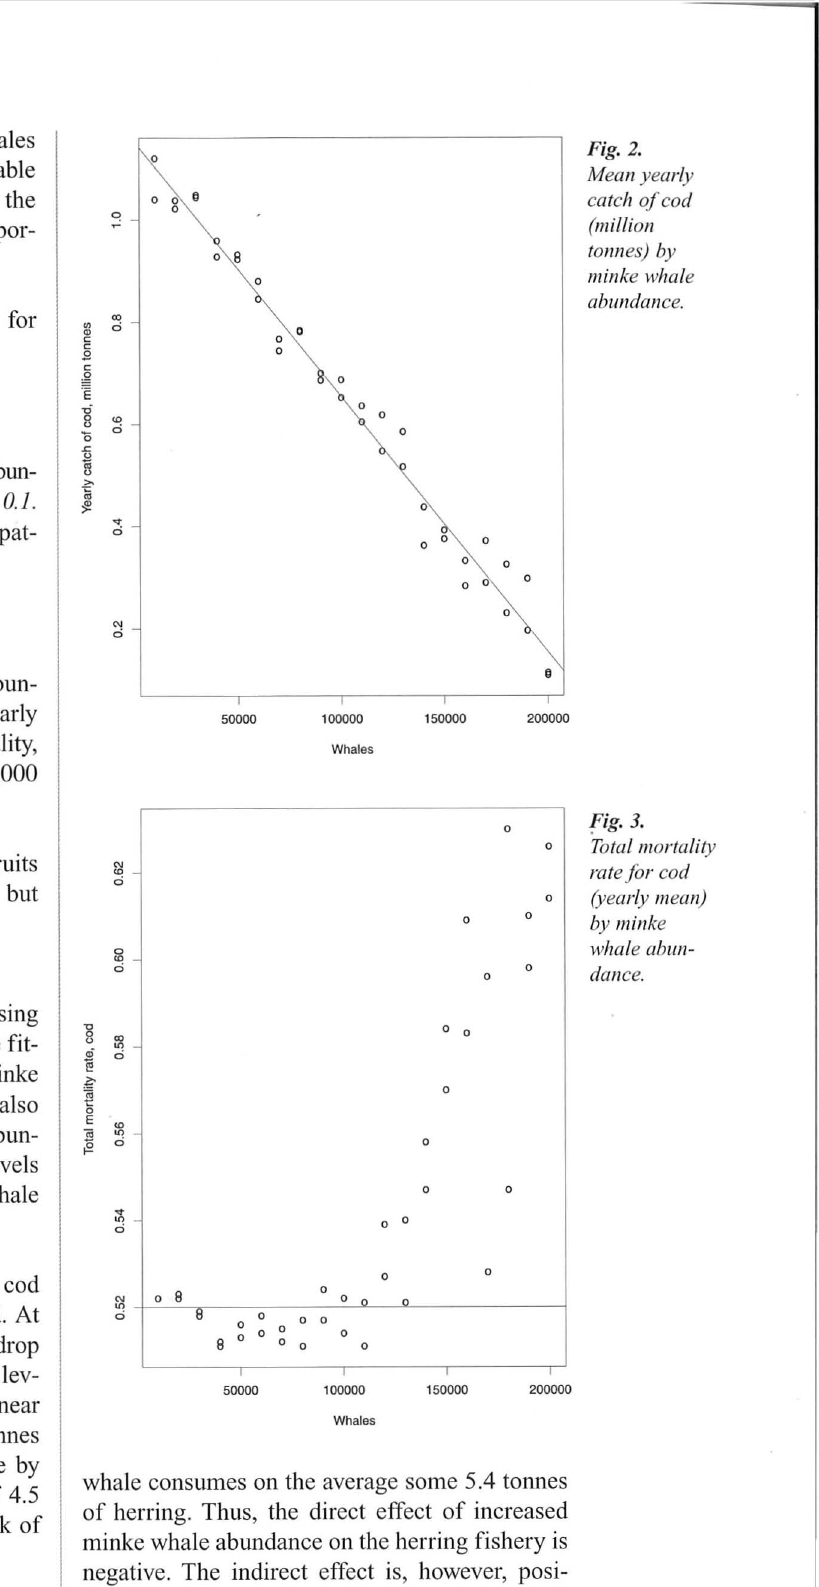
Fig. 2. Mean yearly catch o/cod (million tonnes) by minke whale abundance.